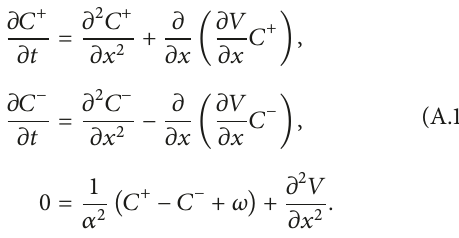
/𝐷 ratio = 10 concrete coating